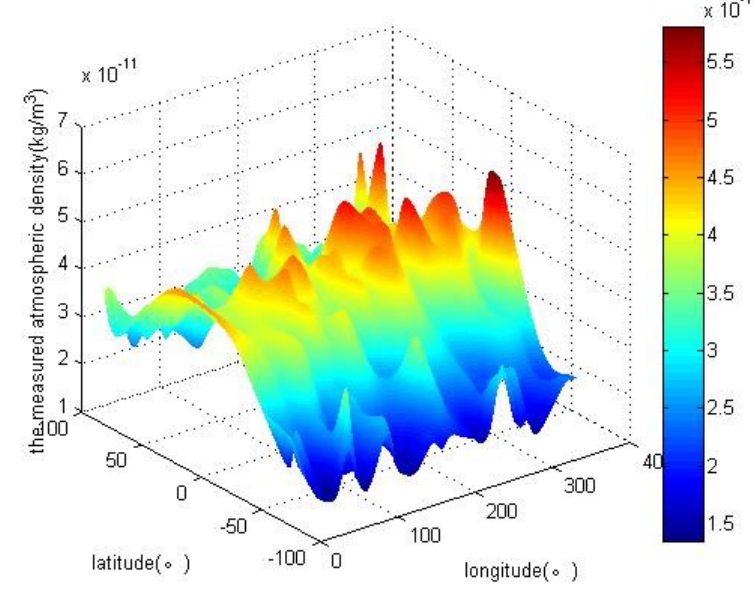
Fig. 5. Global atmospheric density F 10.7 data measured by GOCE in March 2012